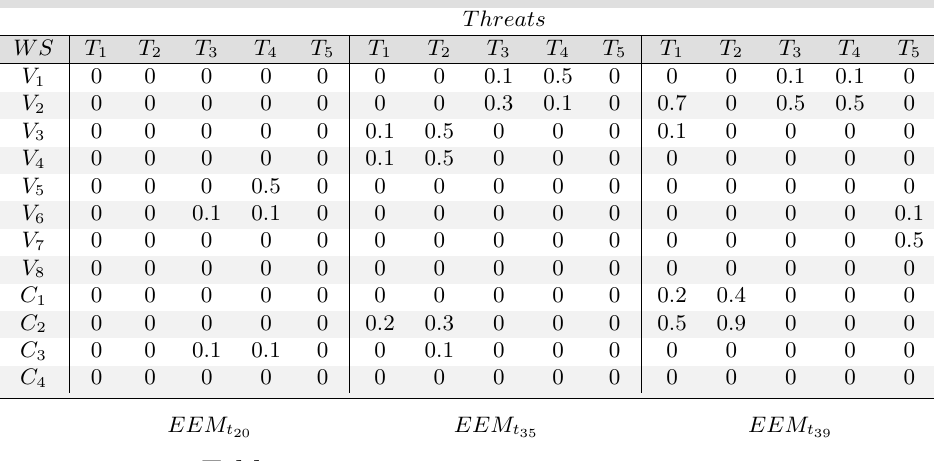
and t 20 , t 35 39